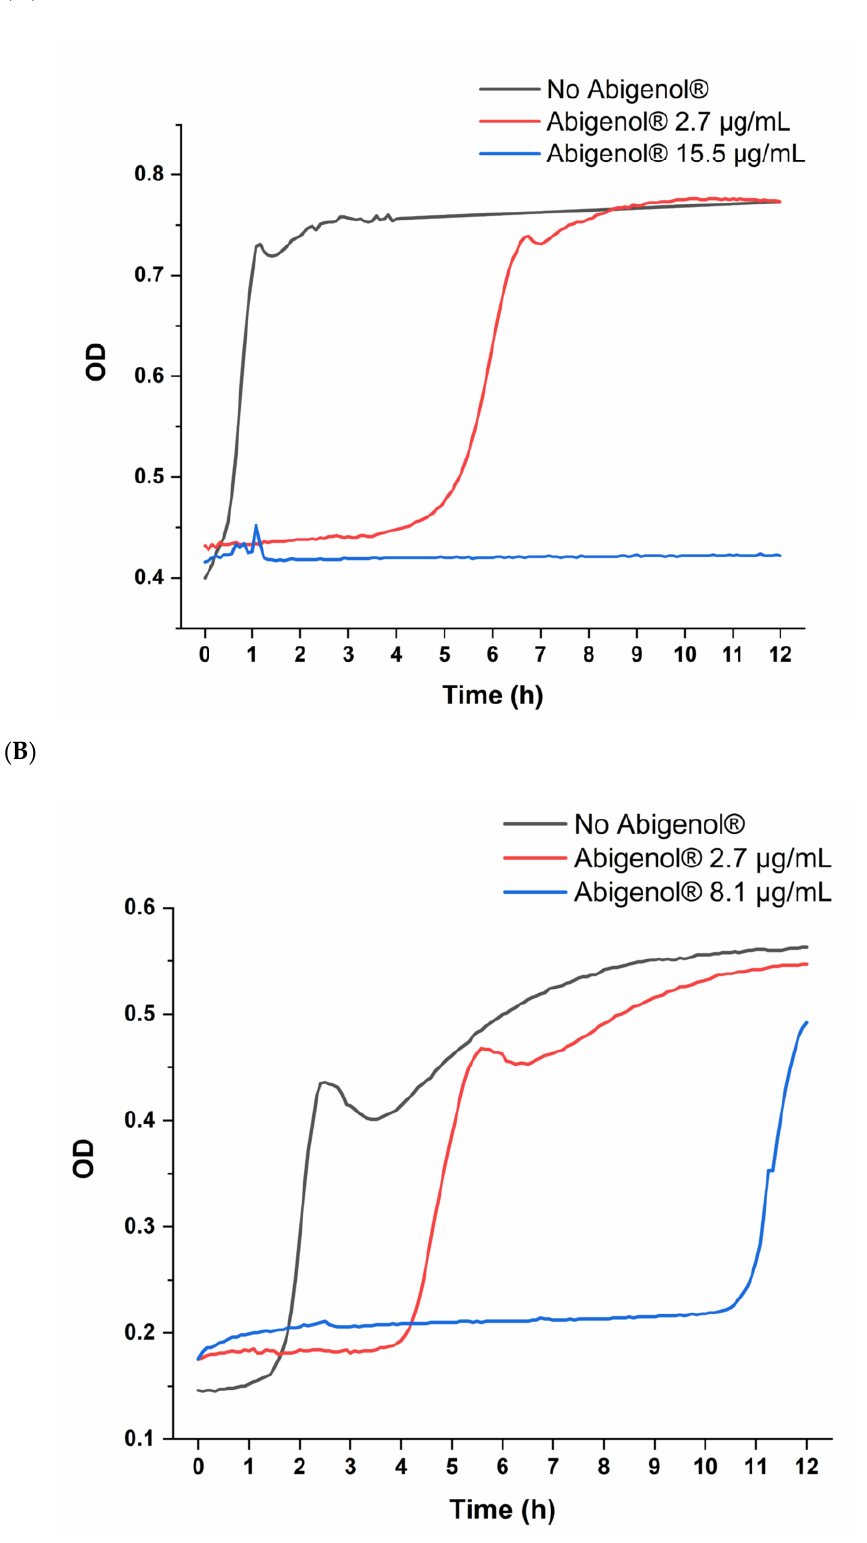
Figure 8. Effects of the silver fir extract on the oxidation of HDL ( A ) and LDL ( B ), induced by exposure to the pro-oxidant copper sulphate. The kinetics were monitored by reading the absorbance at 234 nm for 12 h at 5 min intervals.